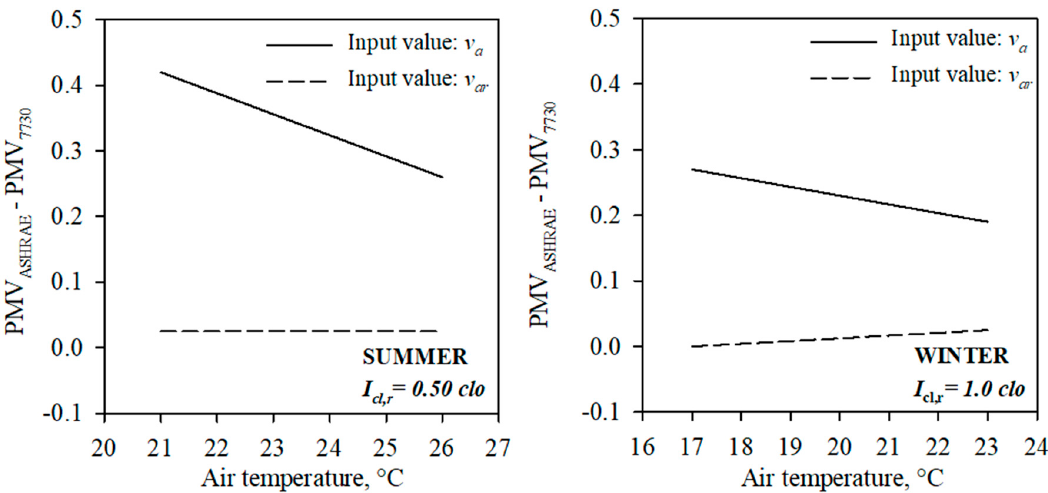
Figure 3. Difference between PMV values calculated by means of the ASHRAE Thermal Comfort Tool and tables reported in the Annex E of ISO 7730 Standard by using as input value air velocity (continuous lines) and relative velocity (dashed lines). M = 1.6 met; t a = t r = t o ; v a = 0.10 m s − 1 ; RH = 50%.